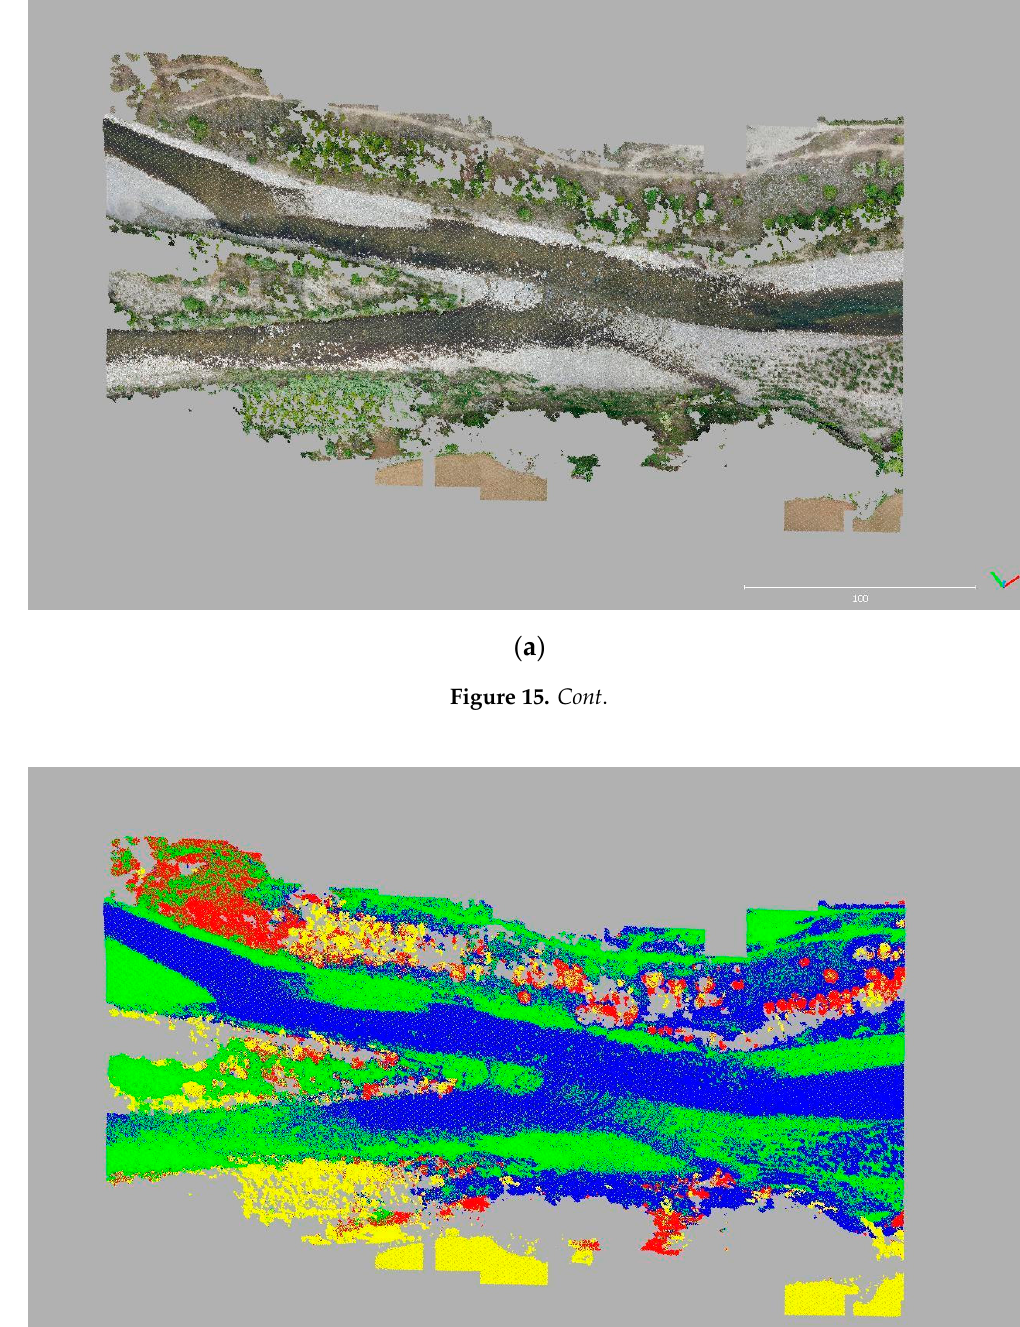
Figure 14. Confusion Matrix sketch in ML classification processing.